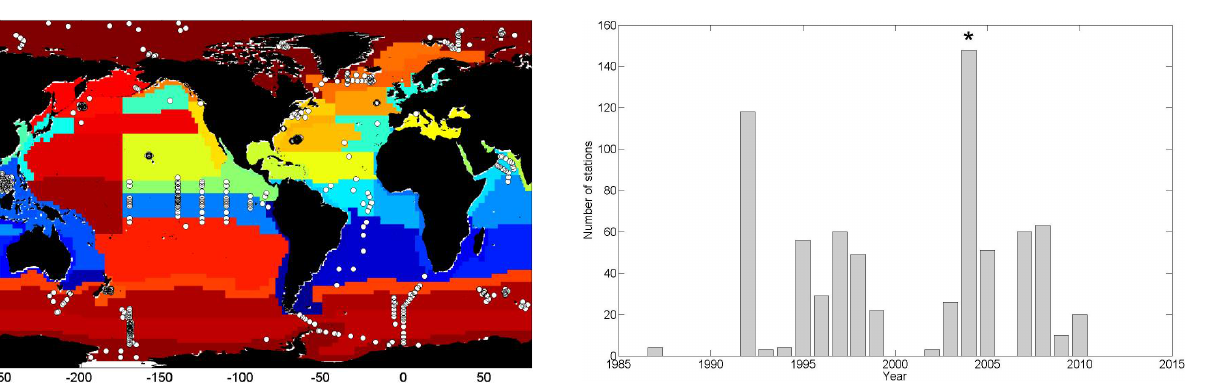
Figure 2. Map showing the distribution of sampling stations. Longhurst oceanic (Longhurst, 2006) provinces are represented in different colours.